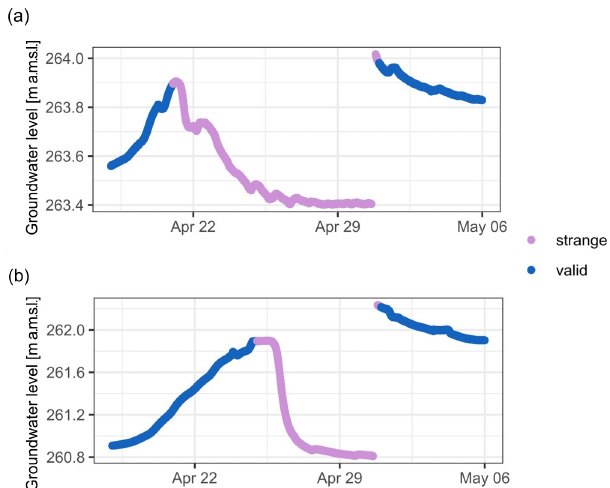
Figure 7. Examples of strange drops in the measured water level during the 2019 spring melt period for two wells (well A4 in panel a and well A21 in panel b